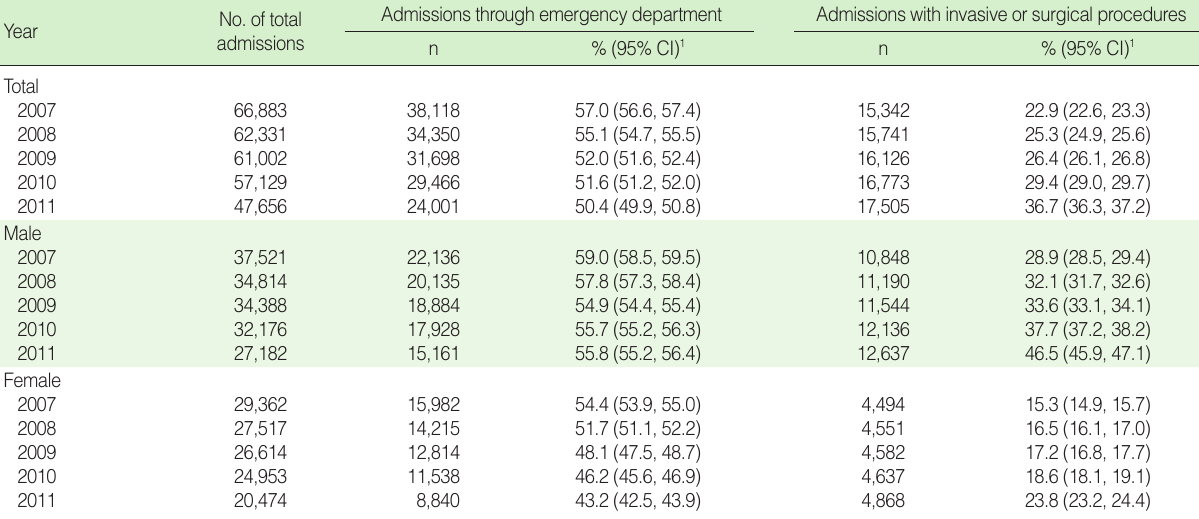
Table 3. Proportions of admissions through the emergency department and admissions involving invasive or surgical procedures among total admissions for acute myocardial infarction by sex and year Year